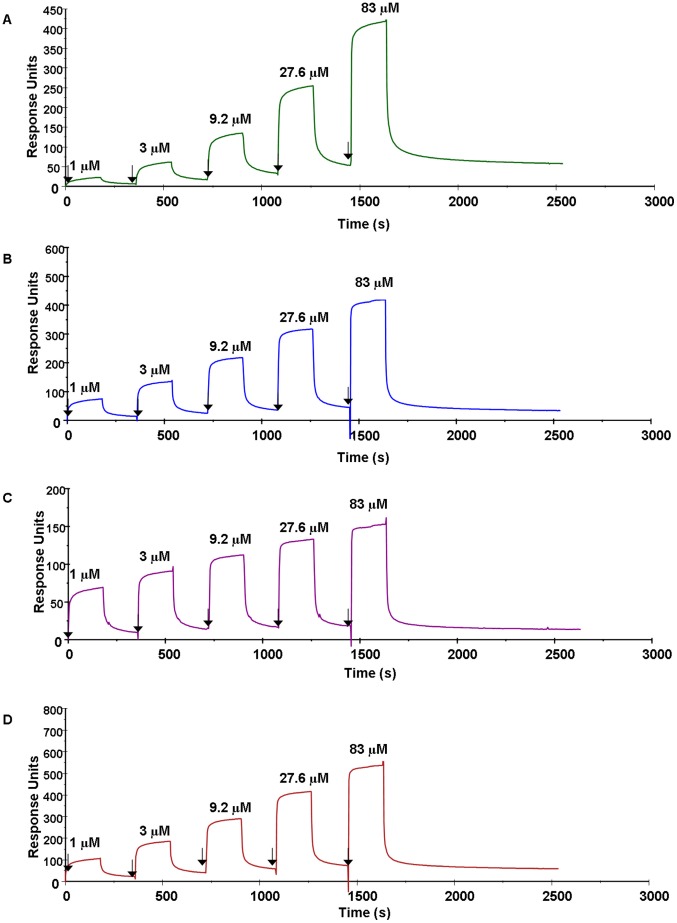
Surface Plasmon Resonance analysis of the interaction of ClfB with loricrin and keratin.Representative sensorgrams display binding of rClfB201–542 to and dissocation from (A) GST-HLor, (B) GST-HK10, (C) GST-MLor and (D) GST-MK10 in a single cycle kinetics assay. GST-tagged ligands were captured onto a CM5 chip coated with anti-GST IgG and were exposed to increasing concentrations of rClfB201–542. Binding is measured as response units (RU) against time. The affinities were calculated from curve fitting to a plot of the RU values against concentrations of rClfB201–542. Arrows indicate the time at which rClfB201–542 is injected. The data shown is representative of 3 individual experiments.